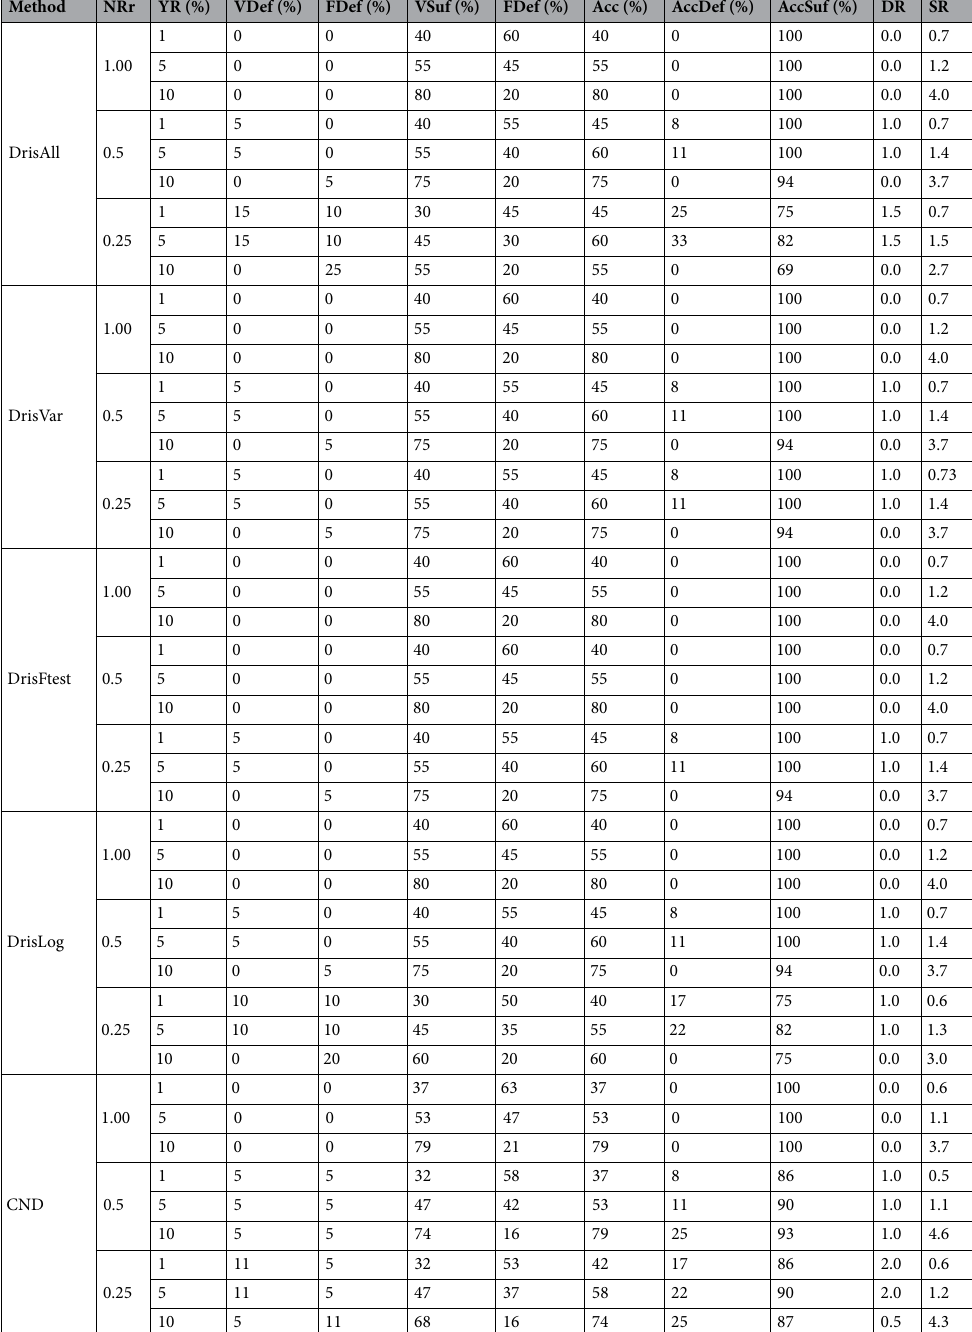
Table 3. Percentage of identified cases of diagnoses true deficiency (TDef), false deficiency (FDef), true sufficiency (TSuf), false sufficiency (FSuf); accuracy (Acc); deficiency ratio (DR), sufficiency ratio (SR) accuracy for deficiency (AccDef), accuracy for sufficiency (AccSuf) obtained by the diagnosis of the DRIS and CND methods as a function of the nutrient responsiveness range (NRr) and yield response (YR) of the nutritional status of foliar boron in a soybean cultivar, in Chapadão do Sul, Mato Grosso do Sul, Brazil. DRIS method adopting the criteria of selecting all bivariate relations—DrisAll, using the criterion Ratio of Variances—DrisVar, using the F test—DrisFtest and using the logarithmic transformation—DrisLog and compositional nutrient